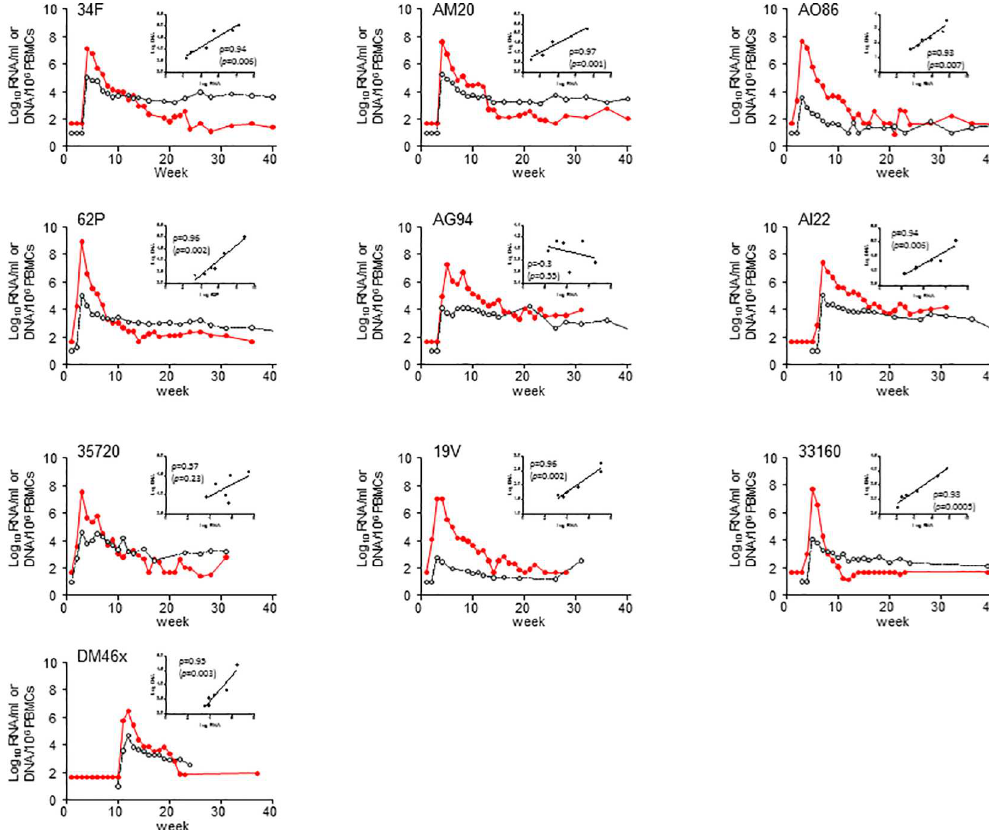
Fig 1. Acute plasma RNA and cell-associated SHIV DNA levels in macaques infected with SHIV 162P3 . Time 0 denotes peak plasma viremia. SHIV RNA levels in plasma are shown in red. Cell-associated SHIV DNA levels in PBMCs are shown in black. Small panels indicate the correlationbetween plasma RNA and DNA levels seen between peak viremia and week 5. Pearson correlationcoefficients are also